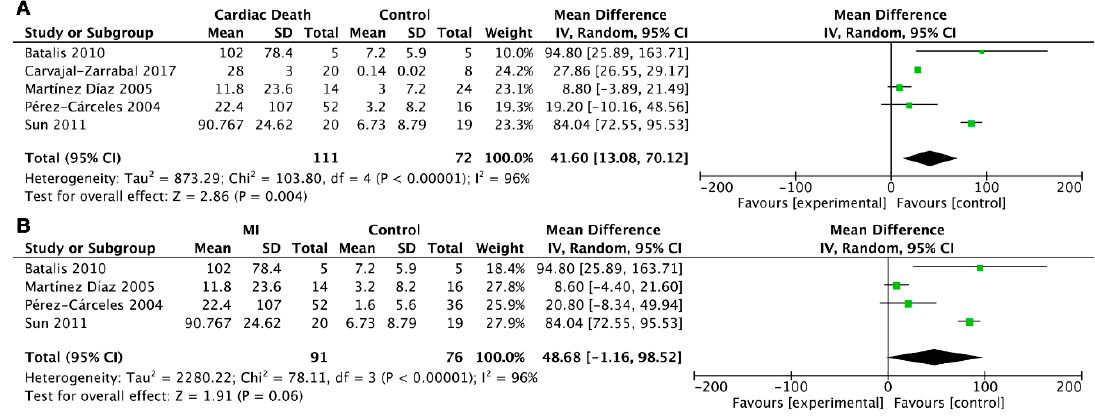
Figure 3. Forest plot of cTn T in pericardial fluid between cardiac death and control groups.